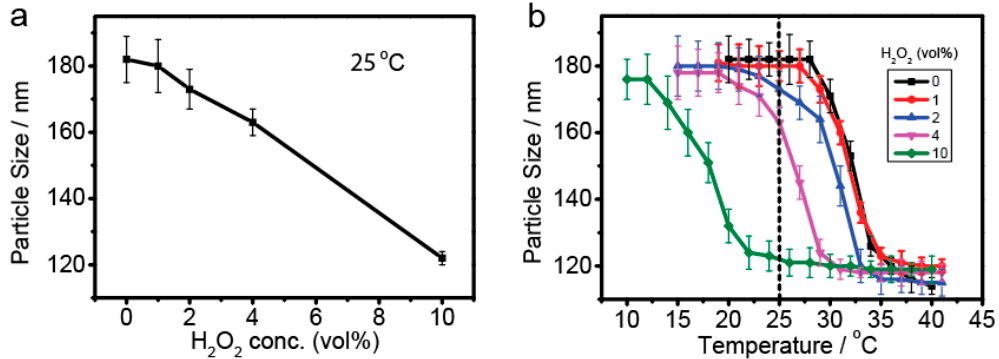
Figure 2. ( a ) The particle size of the PtNP-free brush particles in various H 2 O 2 concentrations as measured by DLS at 25 °C. ( b ) Size variation of the PtNP-free brush particles versus temperature in various H 2 O 2 concentrations by DLS measurement. Table 1: Data for the brush nanomotor in pure water and hydrogen peroxide with different concentrations.